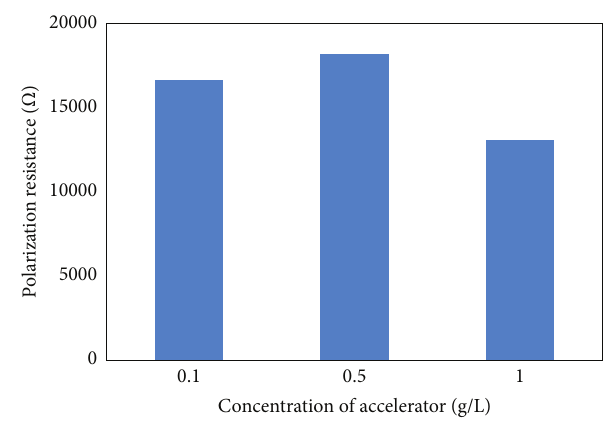
Figure 3: Polarization resistance values for Al samples treated with CeCC for different accelerator